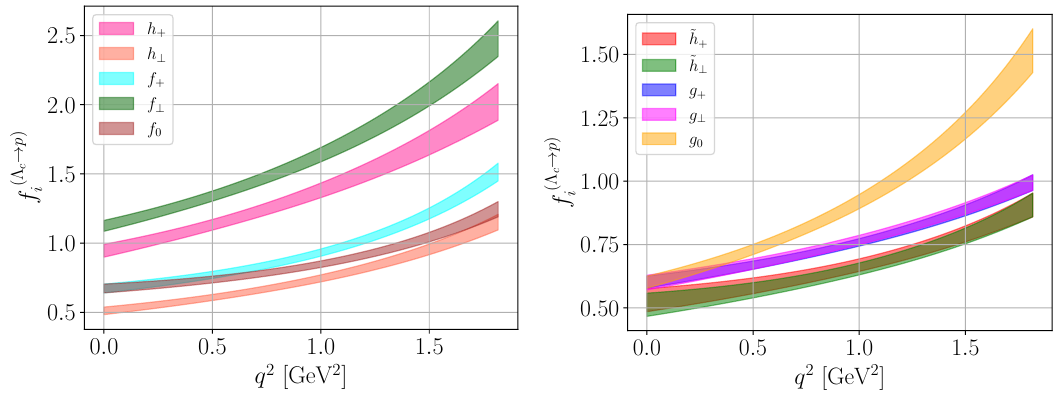
Figure 10 . The Λ c → p form factors from lattice QCD [9] with 1 σ uncertainties.